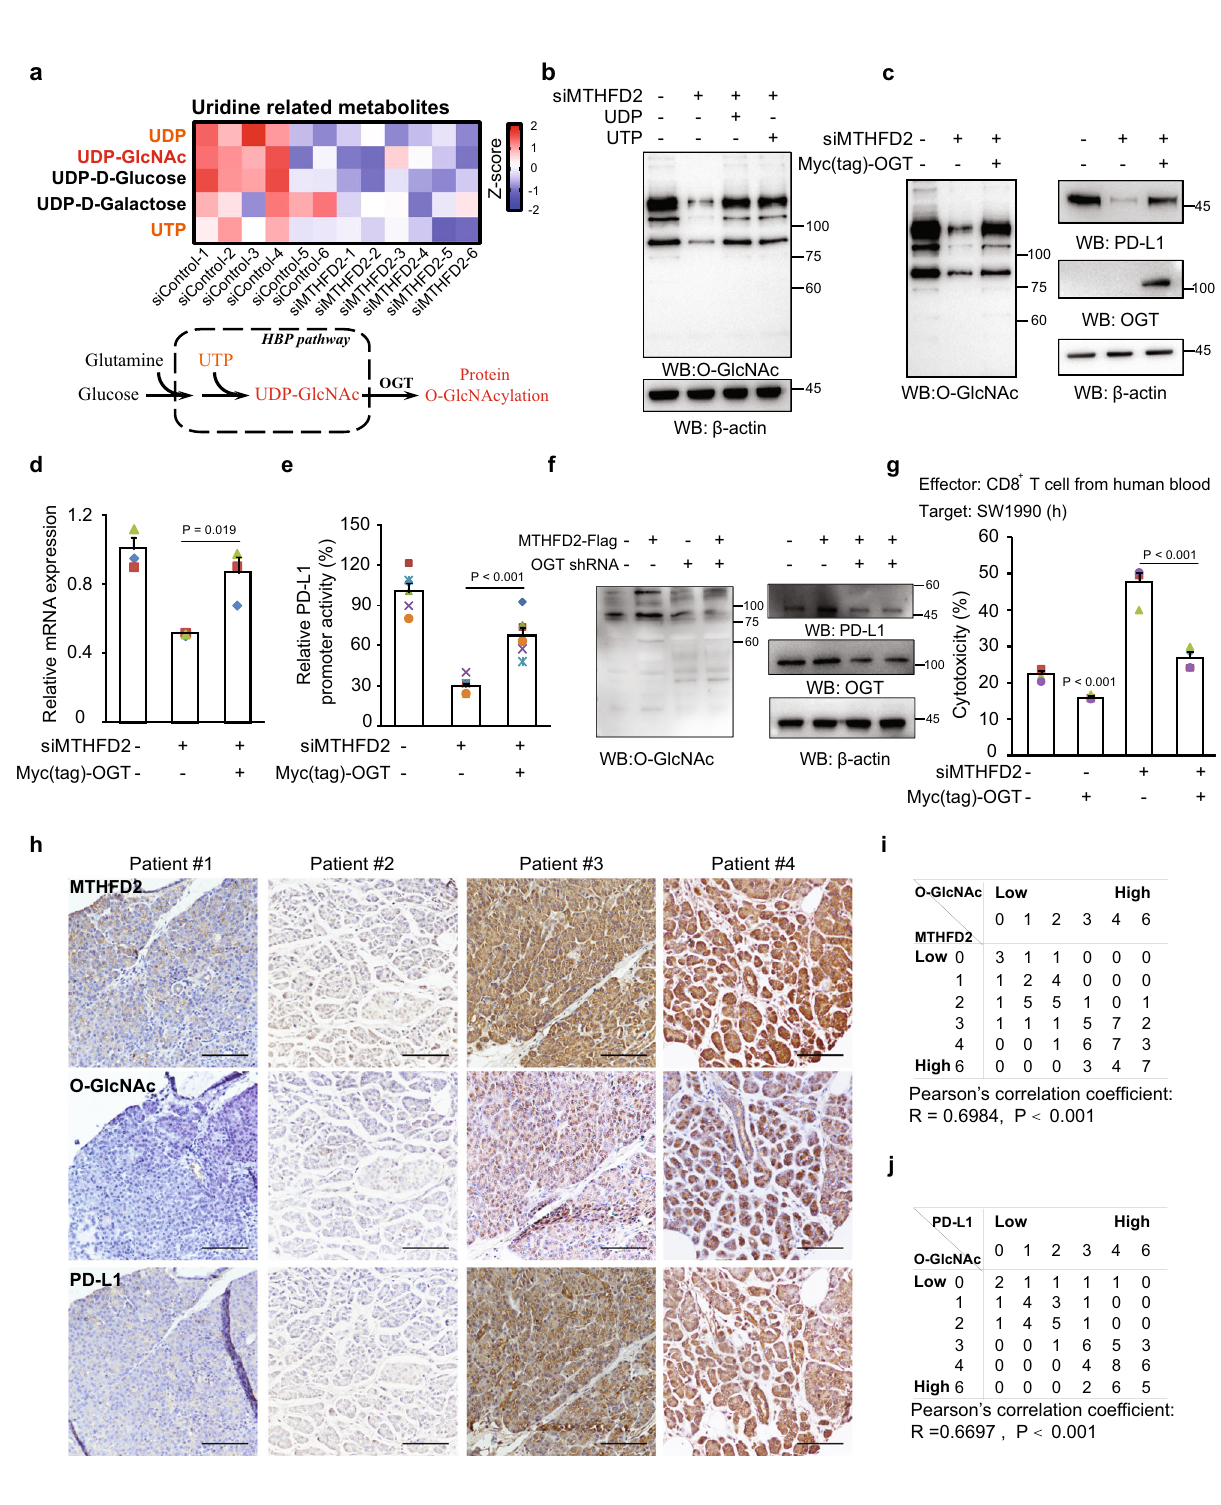
Fig. 4 Metabolic function of MTHFD2 promotes protein PD-L1 transcription through uridine-related-metabolites. a – b , MTHFD2-KO SW1990 cells and HPDE cells transfected with indicated expressing vectors, PD-L1 mRNA levels were analyzed by real-time PCR ( a ) and immunoblotting analyses were performed using the indicated antibodies ( b ). c The metabolomics analysis in SW1990 cells with siMTHFD2 (n = 6 independent samples). d – g SW1990 cells were treated with indicated concentration of indicated metabolites for 24 h, immunoblotting analyses were performed using the indicated antibodies ( d , e ) and PD-L1 mRNA levels were analyzed by real-time PCR ( f , g ). h , i SW1990 cells with siMTHFD2 were treated with 0.3 mM UDP or 0.6 mM UTP for 24 h, PD-L1 mRNA levels were analyzed by real-time PCR ( h ) and the transcriptional activity of PD-L1 promoter (from 2000 bp to 0 bp) is examined by a luciferase-based reporter assay ( i ). In ( a ) and ( f – i ), the values are presented as mean ± s.e.m ( n = 3 independent experiments); p values (Student ’ s t test, two-sided) with control or the indicated groups are presented (also see Supplementary Fig. 4).